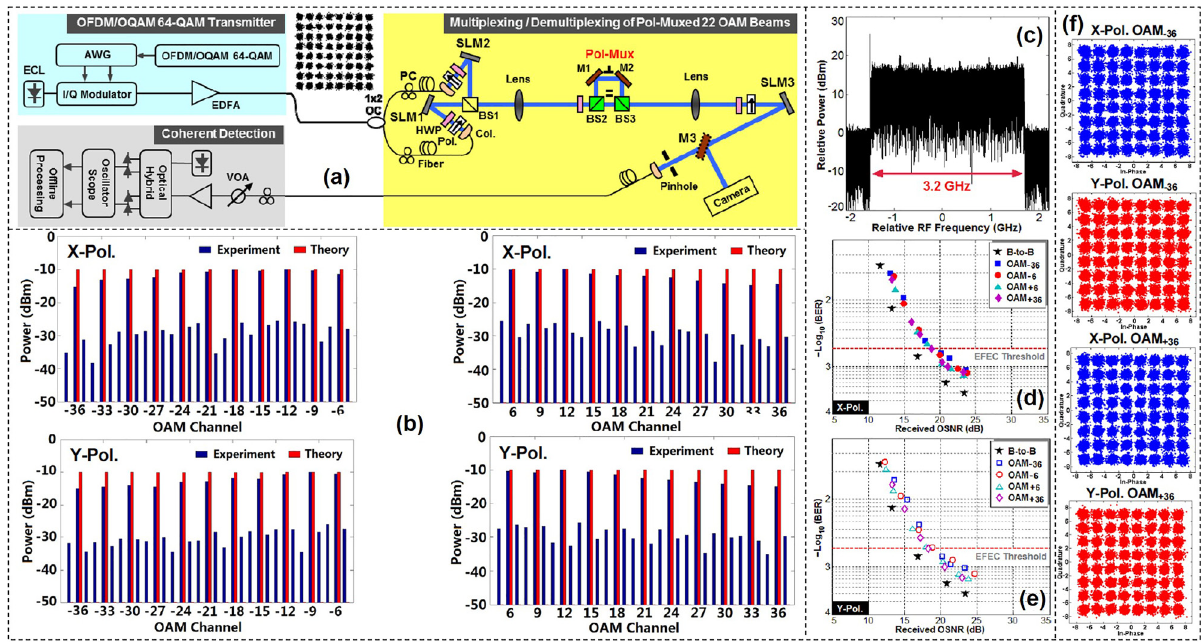
Figure 9: OAM multiplexing communications with a spectral effciency of 230 bit/s/Hz. (a)ExperimentalsetupforOAMmultiplexing/demultiplexing(OFDM/OQAM64-QAMsignalsoverpol-muxed22OAMbeams).ECL:externalcavity laser,AWG:arbitrarywaveformgenerator,EDFA:erbium-dopedfiberamplifier,OC:opticalcoupler,PC:polarizationcontroller,SLM:spatiallight modulator, Col.: collimator, Pol.: polarizer, HWP: half-wave plate, BS1: non-polarizing beam splitter, M1-M3: mirror, BS2-BS3: polarizing beam splitter, VOA:variableoptical attenuator.(b) Measuredpowerdistributionoverpol-muxed 22OAMbeams(44 channels intotal).(c) RFspectrum of demodulated signal. BER curves for (d) X- and (e)Y-polarized OAM − 36 , OAM − 6 , OAM + 6 , OAM + 36 channels. (f) Measured constellations for X-polarized (X-Pol.) OAM − 36 , Y-polarized (Y-Pol.) OAM − 36 , X-Pol. OAM + 36 , Y-Pol. OAM + 36 [85]. Reprint permission obtained from